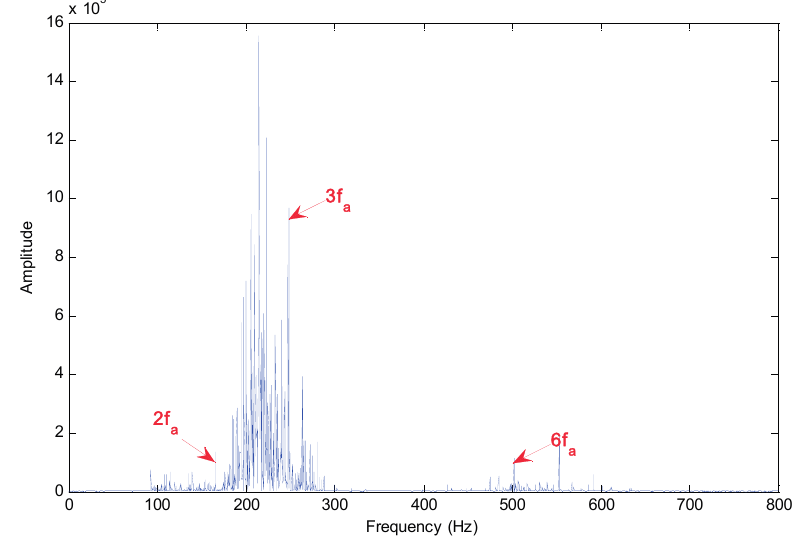
Figure 11. Hilbert marginal spectrum of selected IMFs for axle bearing vibrations with outer ring faults.